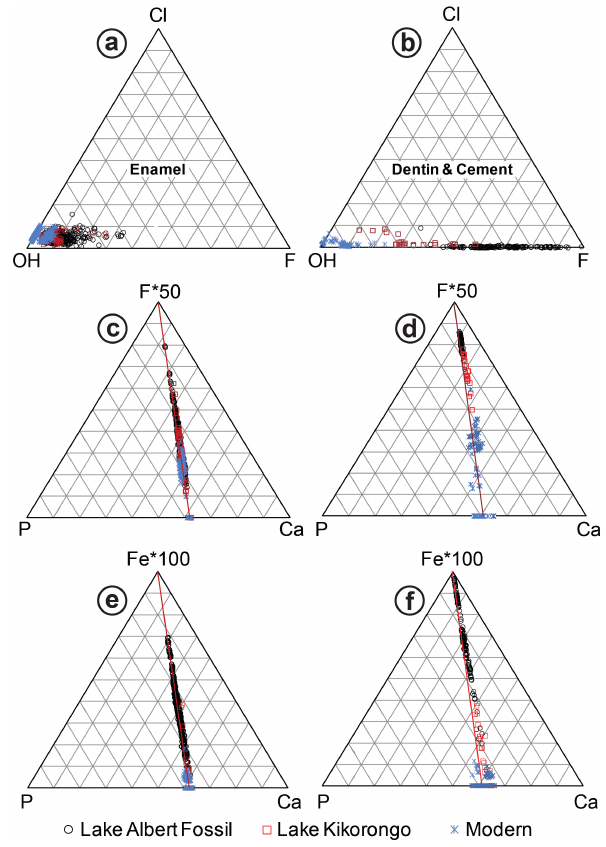
Fig. 5. Chemical components (atomic proportions) in enamel, dentin and cement of modern and fossil Hippopotamid molar teeth indicating the addition of FeO and F during post-mortem alter- ation processes. (a), (c), (e) : distribution of Cl-F-OH, F*50-Ca-P, Fe*100-Ca-P, respectively, in enamel. (b), (d), (e) : distribution of Cl-F-OH, F*50-Ca-P, Fe*100-Ca-P, respectively, in dentin and ce- ment. Red line defines the trend of modern enamel having a rather constant